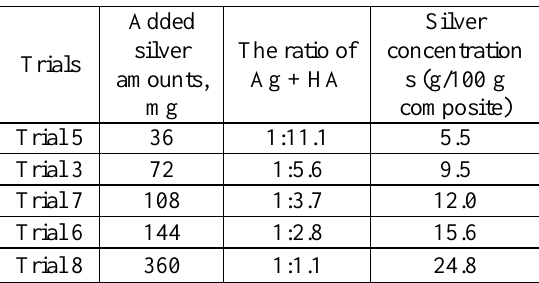
Table 1. Silver concentrations in HA matrix Trials